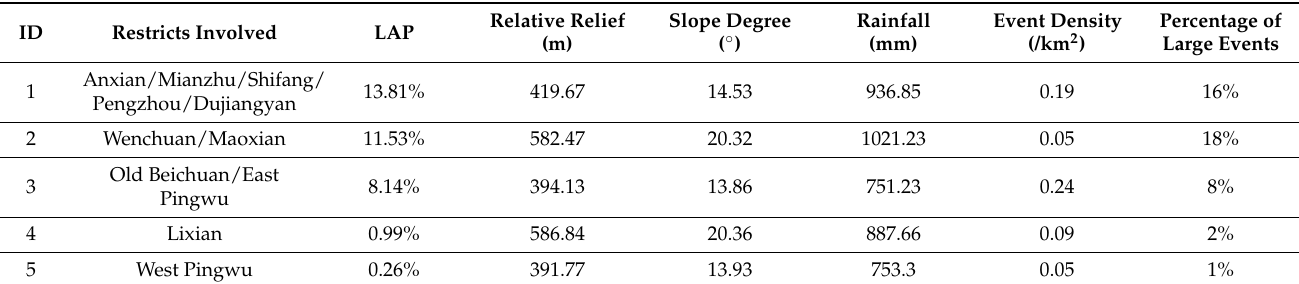
Table 6. Statistical table of background factors and post-earthquake events in each